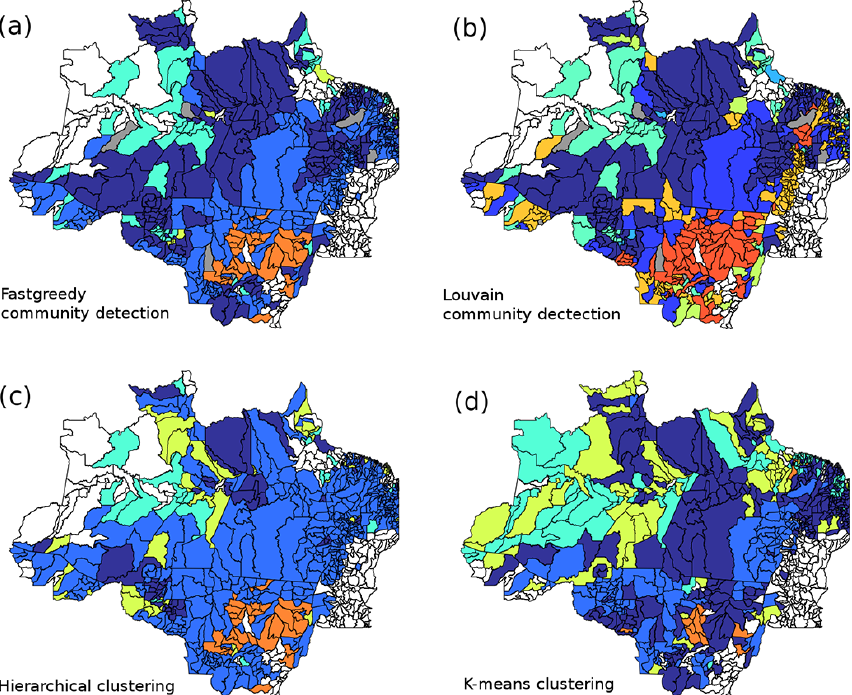
Figure 7. Comparison of network (a, b) and classical (c, d) clustering algorithms for conditional transitions from clean pasture to other land-cover classes between 2010 and 2012. Each cluster is visualized by one color. White regions lack data to estimate the transition matrix, grey regions are not connected to the similarity network. The number of clusters for the hierarchical and k means clusters was chosen to match the outcome of the fast greedy algorithm (five). The Louvain algorithm detects seven clusters.